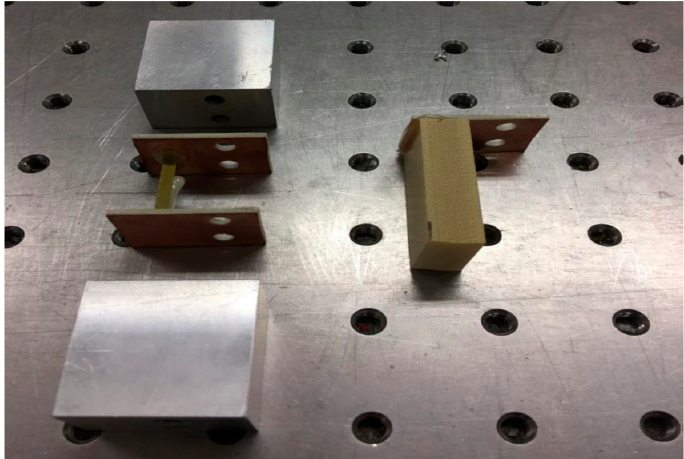
Figure 9. The test specimens with different materials and the aluminum support.